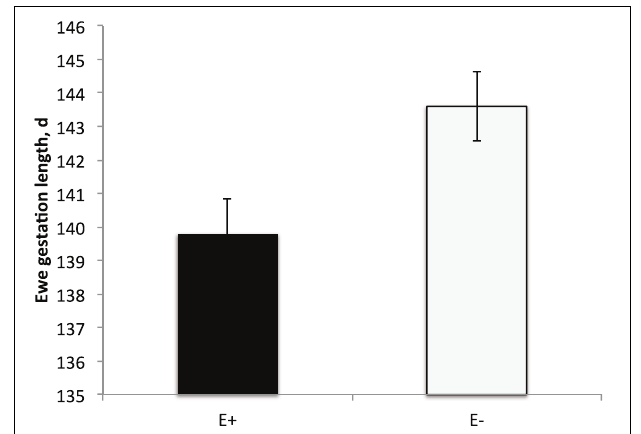
FIGURE 1 | Serum prolactin levels in ewes at d 30, 50, and 130 of gestation. Feeding of tall fescue seed was initiated on d 35 and continued FIGURE 2 | Gestation length (d) of ewes fed tall fescue seed containing